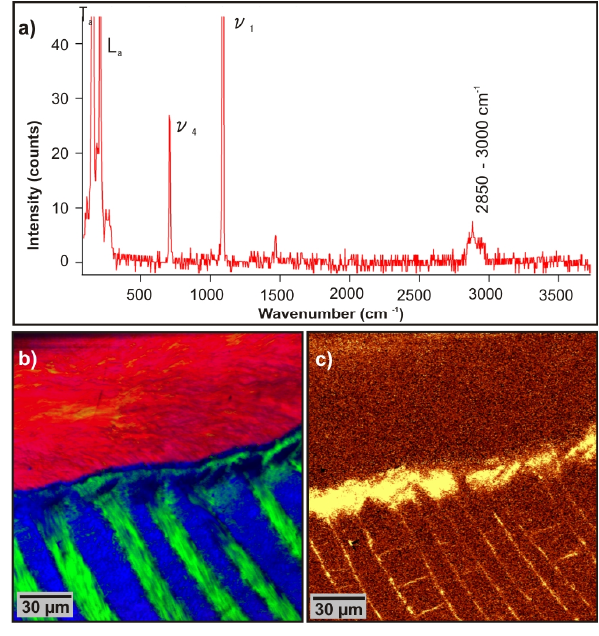
Fig. 4. a) Raman spectra extracted from scan1c showing the typical aragonite spectra and peaks between 2850 - 3000 cm -1 , which correspond to the spectral range for -C-H groups stretching vibrations. b) Map showing the intensity distribution of calcite (red), aragonite_a (green), and aragonite_b (blue) extracted from scan1c. c) Map showing the intensity distribution of the peak between 2850 - 3000 cm -1 , which correspond to the spectral range for -C-H groups stretching vibrations as extracted from scan1c.